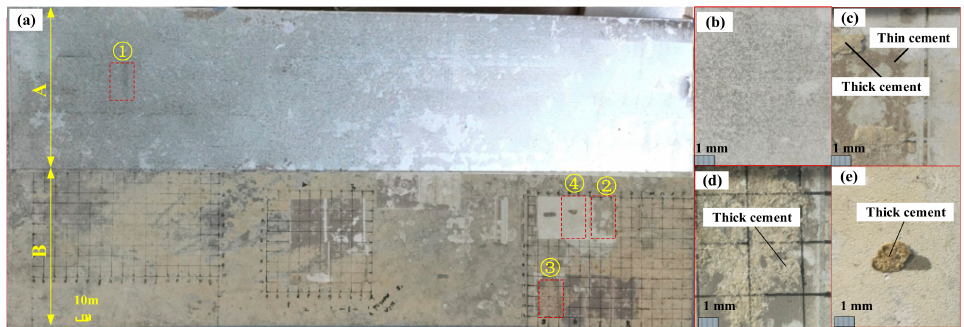
Figure 4. Macroscopic morphology and local magnification of cleaning surface: ( a ) Overall appear-